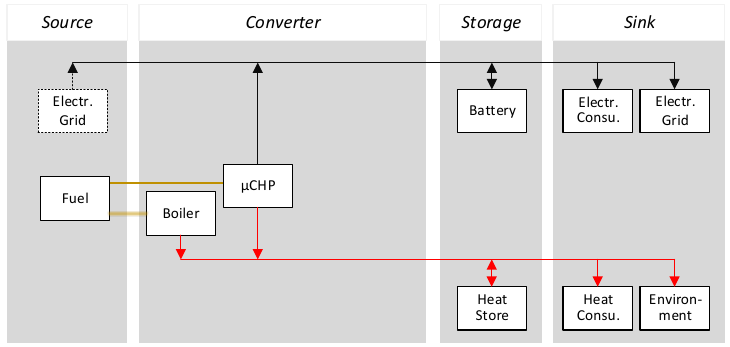
Figure 2. Flow chart of a hybrid stationary SOFC battery supported system with optional grid- connection, heat storage and heat consumption.